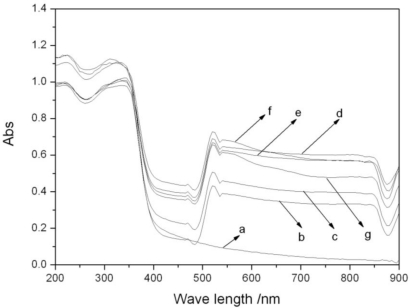
UV-Vis DRS of photocatalysts: (a) TiO2; (b) 0.1%Fe3O4/SiO2/TiO2; (c) 0.25%Fe3O4/SiO2/TiO2; (d) 0.5%Fe3O4/SiO2/TiO2; (e) 1%Fe3O4/SiO2/TiO2; (f) 5%Fe3O4/SiO2/TiO2; (g) 10%Fe3O4/SiO2/TiO2.